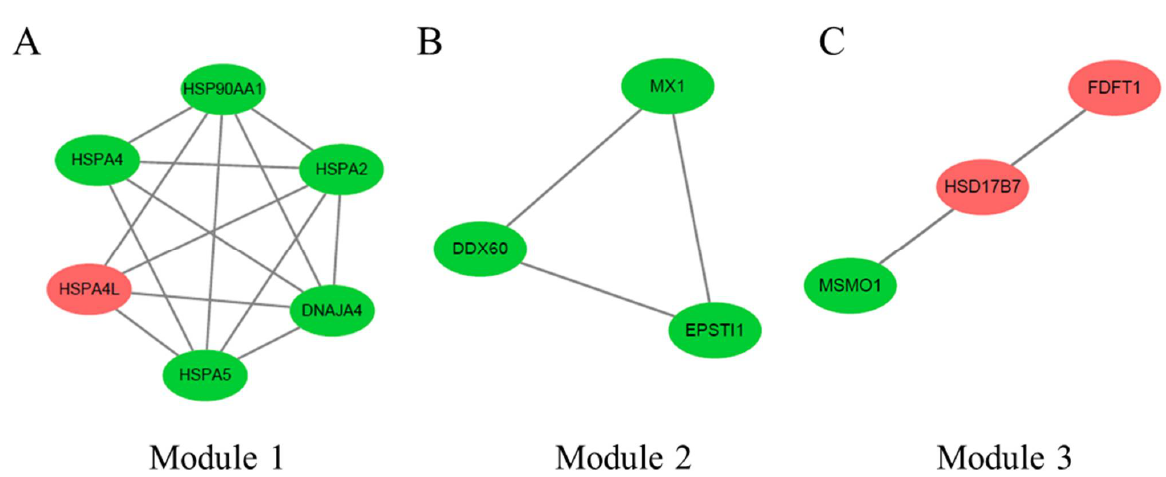
Figure 4. The three protein–protein interaction (PPI) hub network modules were constructed from the PPI network of DEGs between 35 and 12 weeks using MCODE. ( A ) Module 1 (MCODE score = 5.6), ( B ) module 2 (MCODE score = 3), and ( C ) module 3 (MCODE score = 3). The green node represents the downregulated DEGs, and the red one represents the upregulated DEGs.